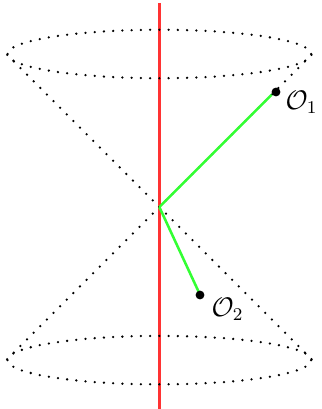
Figure 8 . One of the kinematics corresponding to eq. (4.18), in particular (cid:24) = 1 = ( (cid:16) time-like defect is drawn in red. The operators point on the defect, as demonstrated by the light rays sketched in green. A massless particle with positive energy could be emitted by